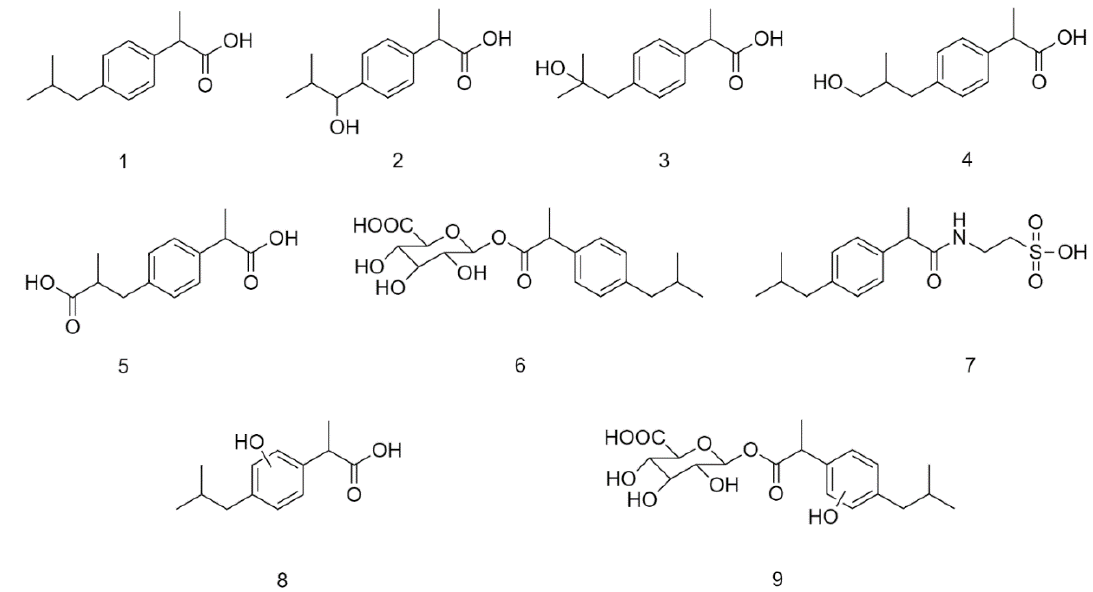
Figure 1 . Structural formula of plausible metabolites of ibuprofen (IBP) ( 1 ): 1-hydroxyibuprofen (1-OH-IBP) ( 2 ), 2-hydroxyibuprofen (2-OH-IBP) ( 3 ), 3-hydroxyibuprofen (3-OH-IBP) ( 4 ), carboxyibuprofen (HOOC-IBP) ( 5 ), ibuprofen- β -D-glucuronide (IBP-GLU) ( 6 ), ibuprofen taurate (IBP-TAU) ( 7 ), hydroxylated ibuprofen ( 8 ), and glucuronide conjugate of a hydroxylated ibuprofen ( 9 ). (The position of the hydroxyl substitution of 8 and 9 is uncertain.)